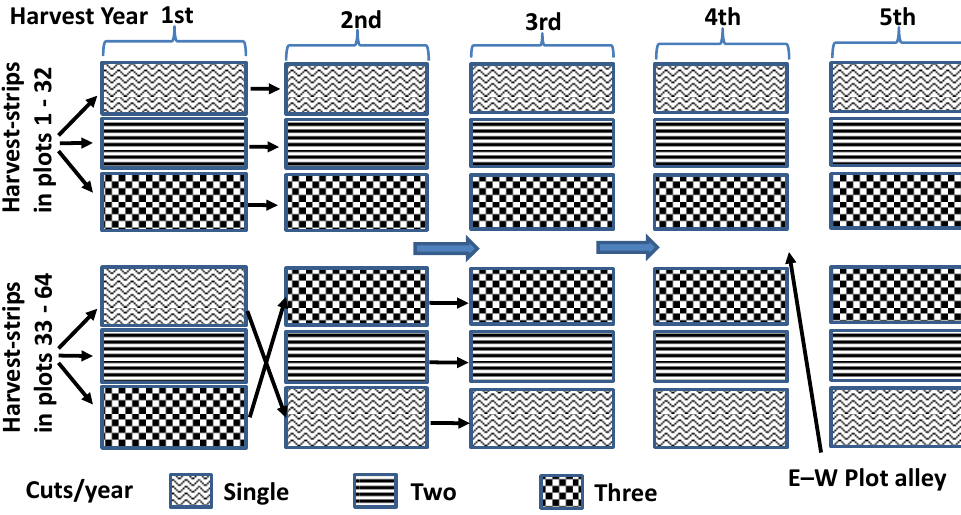
Figure 2. Relative arrangement of harvest-strips within a plot assigned to single, two, or three cuts year −1 , with harvest regimes flipped between the single- and three-cut strips after the 1st year (2014) for plots 32 – 64 and all plots receiving a single late-June harvest in the 5th year (2018). Table 2. The ANOVA F and p values for the main and interaction effects of year, harvest regime (system), species, and harvest frequency (cuts) on single, two, and three cuts per year systems for two-year-old NWSG stands recorded from 2014 to 2018.